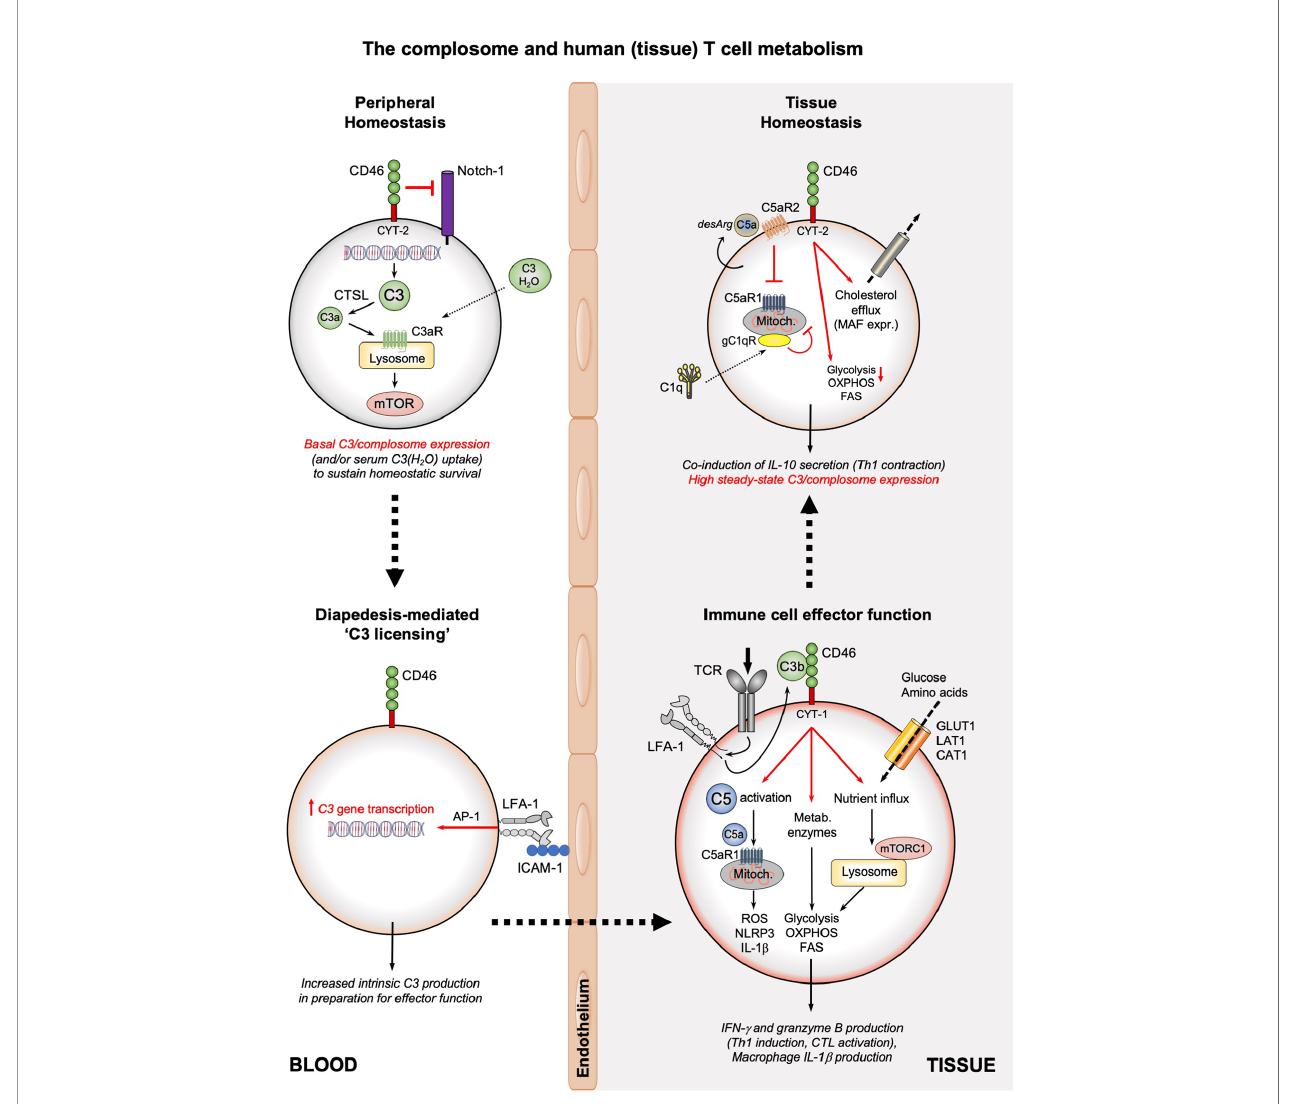
FIGURE 2 | The complosome and human (tissue) T cell metabolism. The survival of circulating, non-activated CD4 + and CD8 + T cells is maintained by low-level expression of C3 (or uptake of C3(H 2 O)) that is continuously cleaved by CTSL into intracellular C3a which supports tonic mTOR activation through the lysosomal C3aR. In addition, CD46 surface expression prevents activating Notch-1 stimulation. Diapedesis of T cells (or interaction with APCs presenting cognate antigen, not shown) into tissue involves engagement of LFA-1 on T cells by ICAM-1 on endothelial cells and induces high C3 gene expression in an AP-1-depenent fashion. Timely incoming TCR signals induce rapid translocation of intracellular C3b to the cell surface, where it engages CD46. CD46 signaling triggers three key metabolic events: the g -secretase-processed intracellular CYT-1 domain of CD46 translocates to the nucleus (not shown) where it induces expression of nutrient transporters (GLUT1, LAT1, and CAT1) as well as LAMTOR5-driven mTORC1 assembly at the lysosomes; CD46 activation induces increased expression of metabolic enzymes, including fatty acid synthase, GAPDH, etc.; CD46 also strongly augments activation of intracellular C5 pools with the intracellularly generated C5a stimulating mitochondrial C5aR1 that drives ROS production and NLRP3 in fl ammasome activation in CD4 + T cells. Together, these events underly the high levels of glycolysis, OXPHOS and ROS production needed speci fi cally for the induction of IFN- g production and granzyme B expression and hence protective Th1 and CTL effector responses in tissues. Of note, macrophages also rely on the LFA-1-mediated process for ‘ C3 licensing ’ to produce normal amounts of IL-1 b upon TLR stimulation (not shown). The complosome also contributes to the safe metabolic ‘ shut-down ’ of human T cell immunity and prevention of tissue pathology as the CD46 intracellular domain CYT-2 reduces glycolysis and OXPHOS while supporting cholesterol ef fl ux and MAF expression, all required for immune-suppressive IL-10 co- induction and demarcating the Th1 contraction phase. This contraction program is further supported by autocrine engagement of the repressive C5aR2 on the T cell surface ( via intrinsic C5a-desArg), which reduces C5aR1 activity. C1q, taken up by the activated T cell can reduce mitochondrial activity (in CD8 + T cells) via a C1qR- dependent unknown mechanism. A de fi ning feature of T cells (and macrophages, not shown) in tissues is their high steady-state expression of the complosome. CAT1, cationic amino acid transporter; CTSL, cathepsin L; FAS, fatty acid synthase/synthesis; GLUT1; glucose transporter 1; ICAM-1, intercellular adhesion molecule 1; LFA-1, lymphocyte function-associated antigen 1; LAT1, large neutral amino acid transporter 1; MAF, cMaf musculoaponeurotic fi brosarcoma oncogene homolog; mTOR, mechanistic target of rapamycin; mTORC1, mechanistic target of rapamycin complex 1; NLRP3, NLR family pyrin domain containing 3; OXPHOS, oxidative phosphorylation; ROS, reactive oxidation species; TCR, T cell